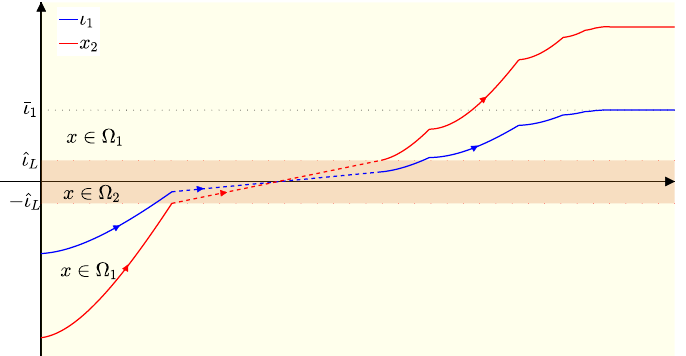
Figure 2. Transition between monotonic Suboptimal SOSMC (37) ( solid line ) and control law (38) ( dashed line